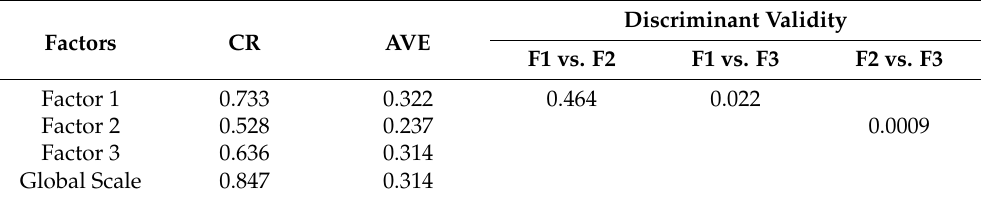
Table 4. Composite reliability, convergent validity and discriminant validity.